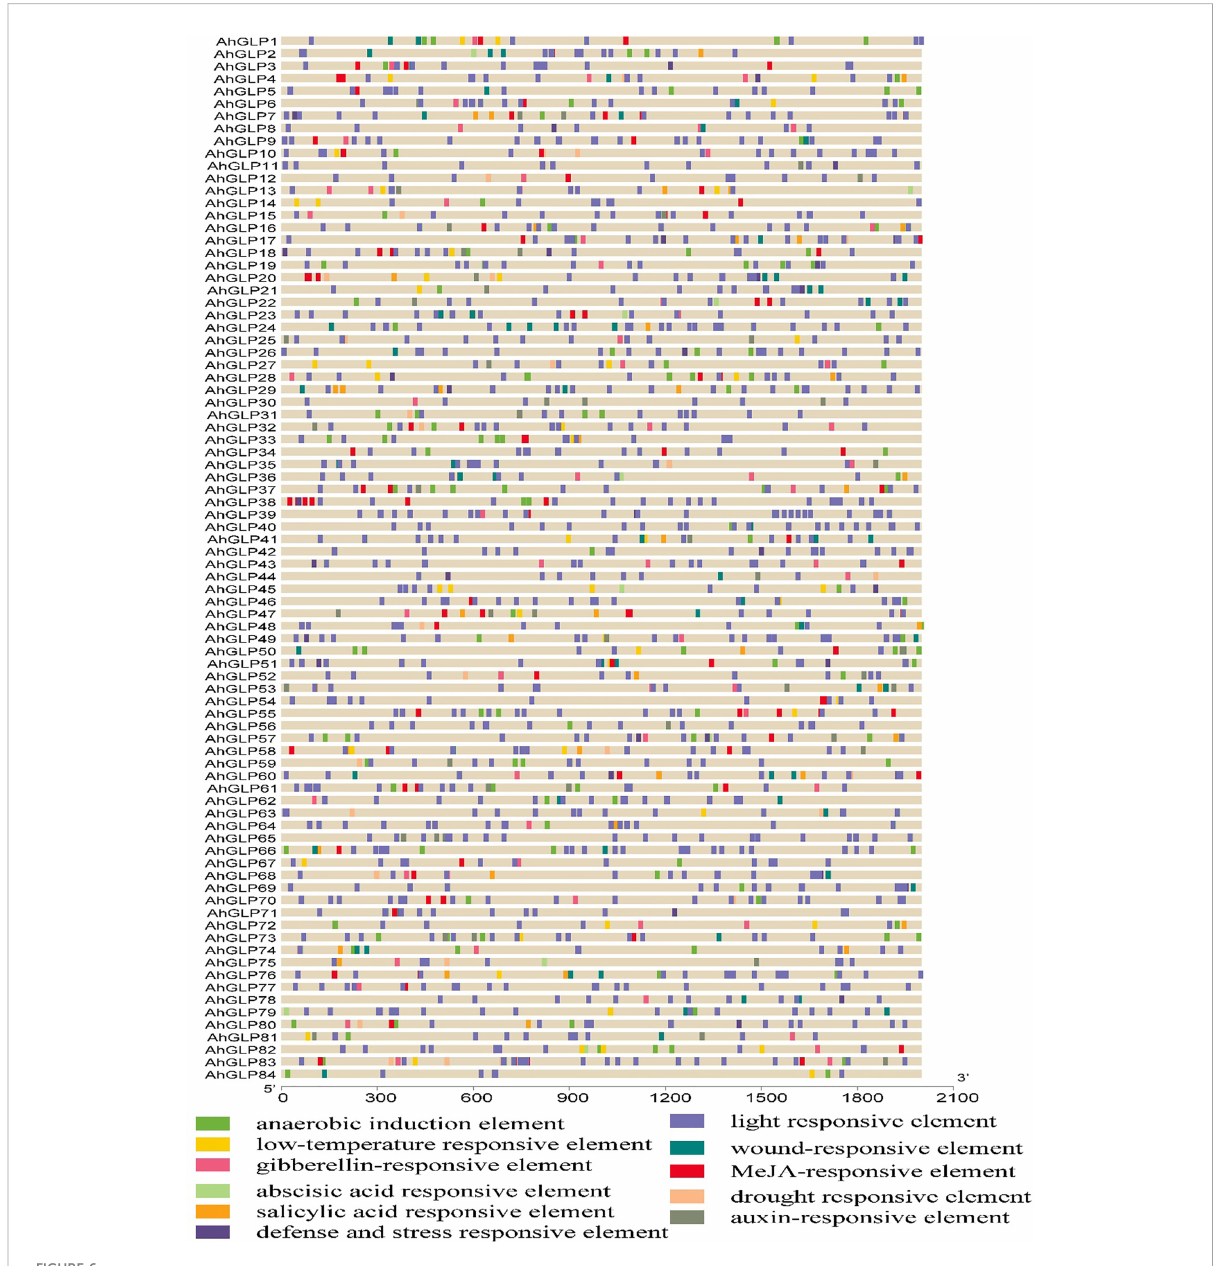
FIGURE 6 Cis -regulatory elements of AhGLP promoters. Cis -elements analysis revealed important elements responsive to light, hormones, growth and development, and stress